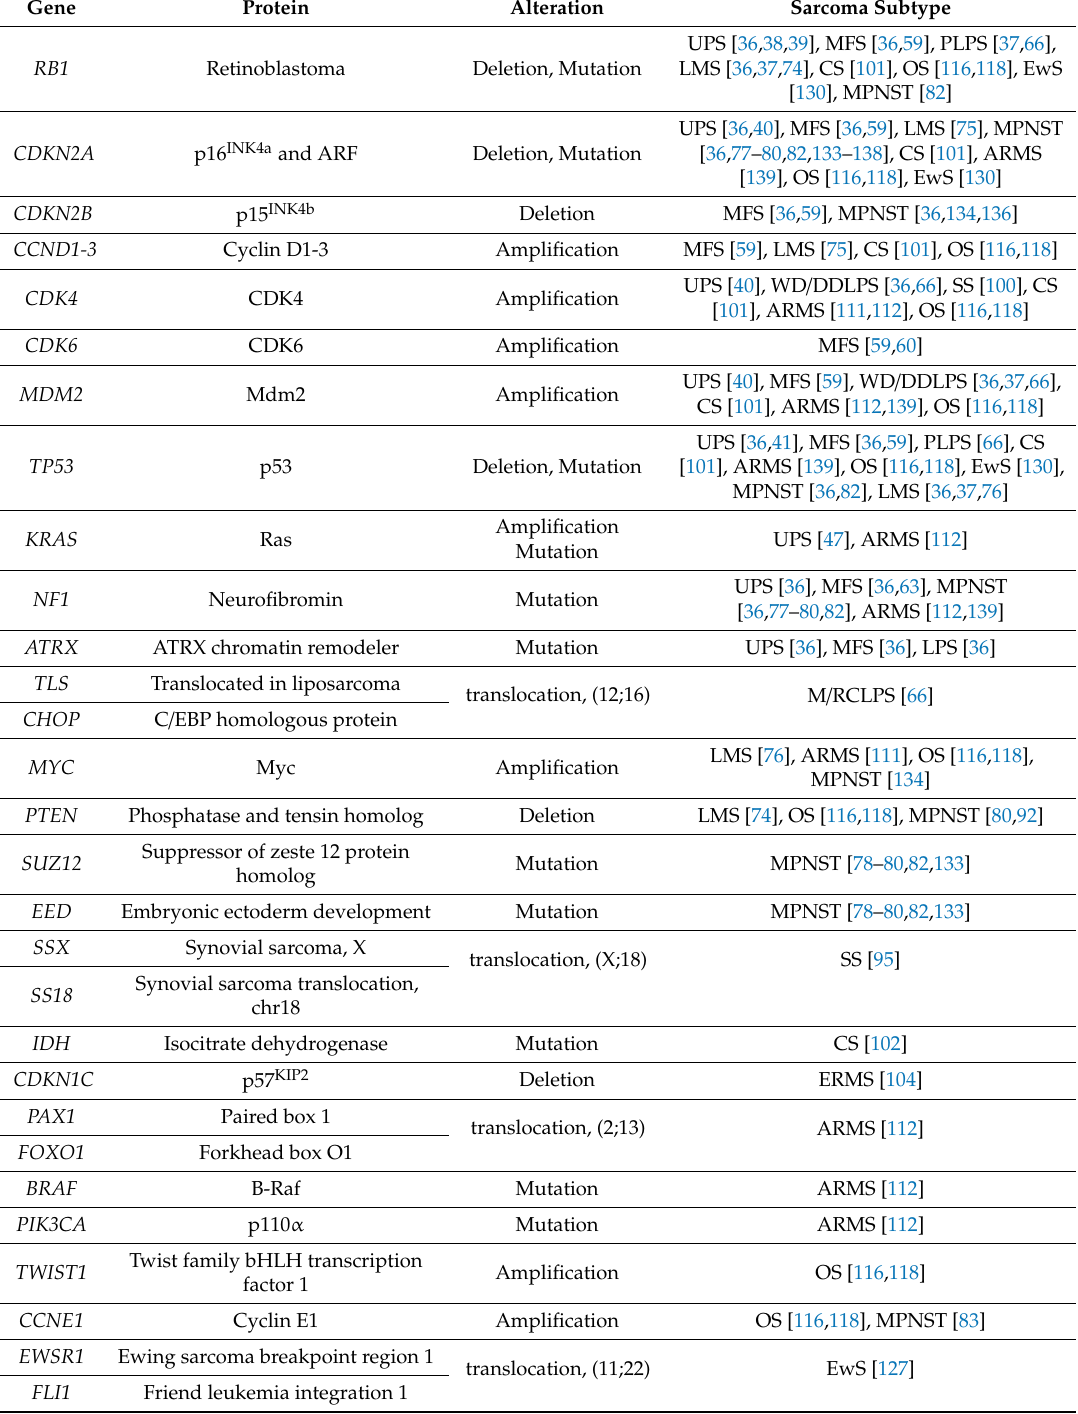
Table 1. Genetic alterations of CDK pathway genes in